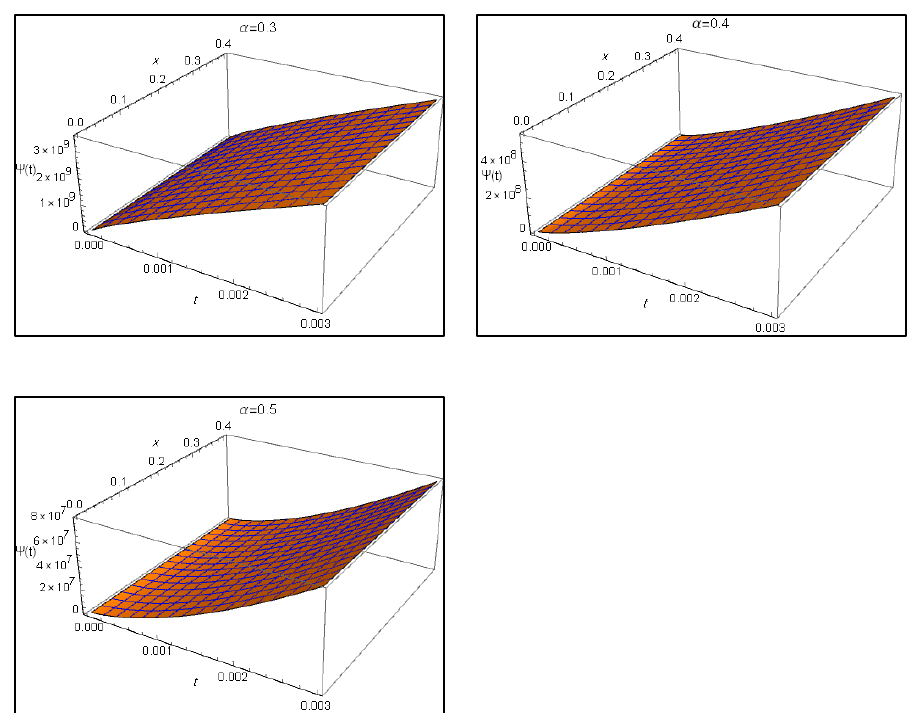
Figure 2. Three-dimensional graphs of neutron flux ψ ( x , t ) with ψ 0 ( x ) = x 2 for α = 0.1, 0.2, 0.3, 0.4 and 0.5 (colored online). Two-dimensional graphs of neutron flux ψ ( x , t ) for α = 0.1, 0.2, 0.3, 0.4, and 0.5 (colored online).